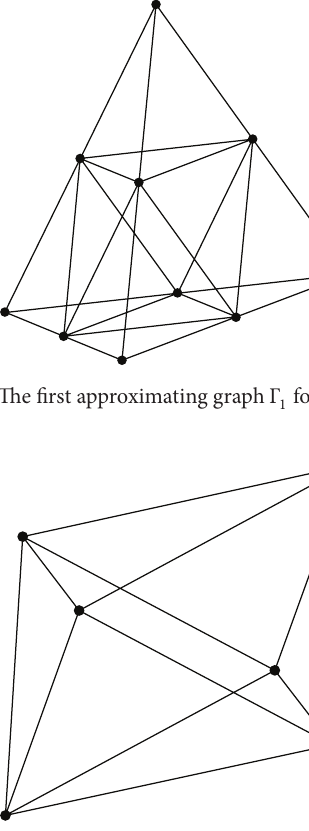
Figure2:Thegraph Γ 1 forthefractal P 4